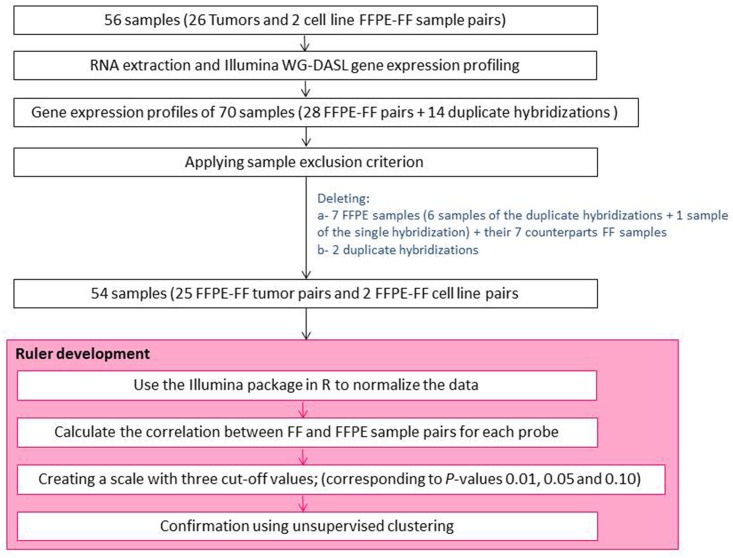
Flow chart of the method followed to analyze FFPE-FF sample pairs.70 FFPE and FF measurements (28 FFPE-FF pairs + 14 duplicate hybridizations) were used to establish a sample-quality threshold. A threshold of 2,208 was chosen and 7 FFPE samples (6x of the duplicates and 1x of the single hybridizations) with a median below this threshold were considered of poor quality and were excluded. Because the analysis is based on FFPE-FF pairs, 7 FF pairs matching the 7 FFPE samples with low median of the reference genes were excluded from the analysis. In addition, to exclude bias in the unsupervised analysis to be performed later, the two samples that remained from the duplicate hybridizations were excluded from the analysis. The duplicate samples were selected based on their median reference gene values; duplicate samples with the lowest median reference gene values were excluded from the analysis. Due to the duplicate hybridizations which did pass the exclusion criteria, only 1 sample pair was lost to the analysis because there was no FFPE data available. The other 25 tumors and 2 cell lines had all FFPE and FF data available for further analyses In total, 54 FFPE-FF measurements (27 FFPE-FF sample pairs) were used to develop the ruler based on the reliably measured probes.